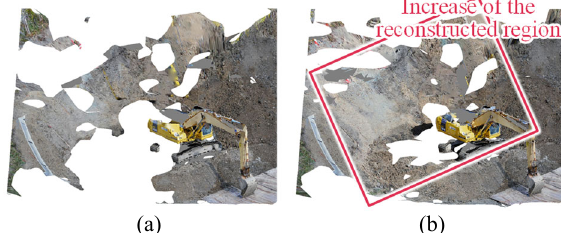
Figure 14. The result of the final textured mesh model; (a) before adding an image and (b) after adding an image.